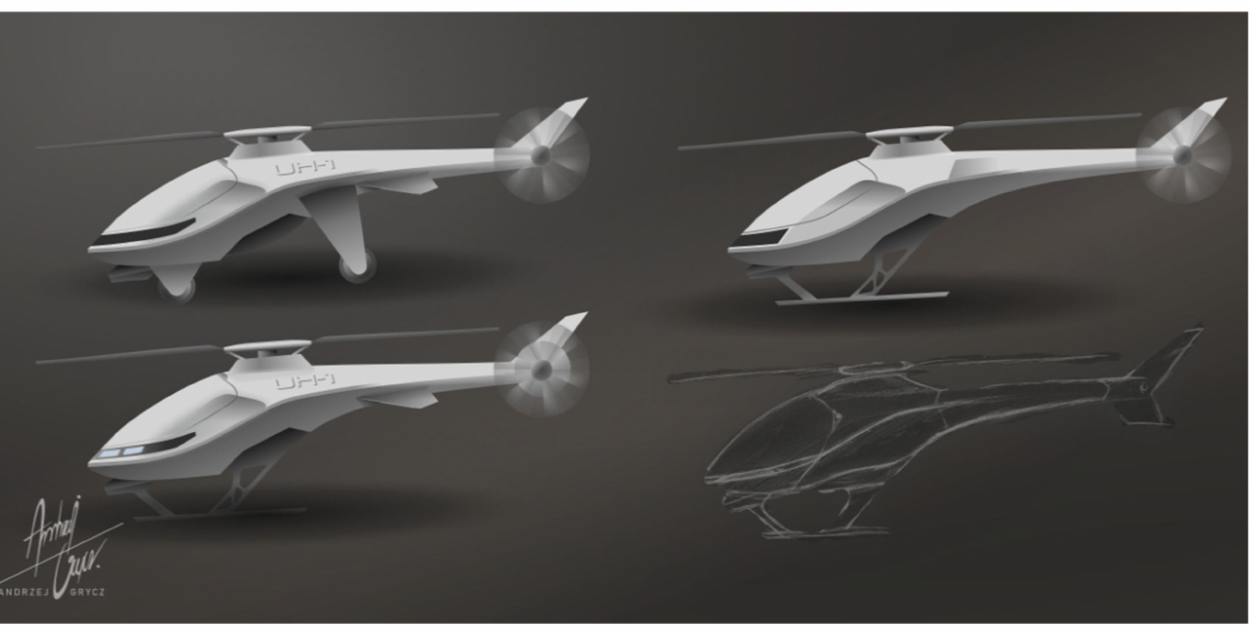
Figure 1. Design variations of the unmanned aerial vehicle (UAV) (drone) (own sketch design, based on